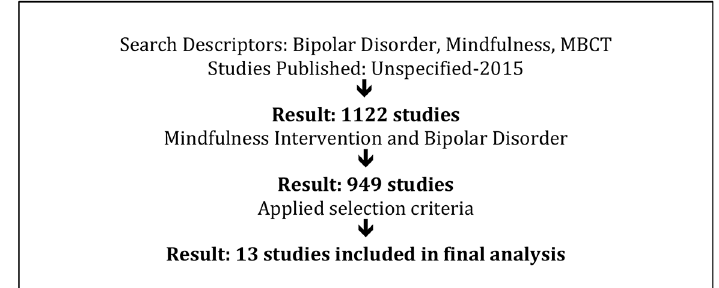
Figure 1. Flow chart of study inclusion/exclusion